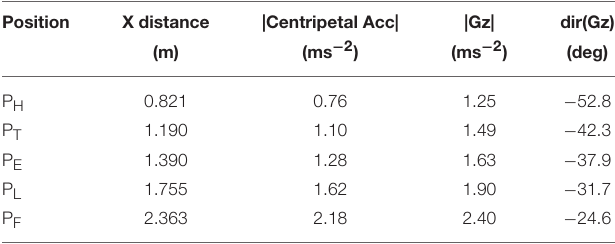
TABLE 1 | Resultant dynamics at five points along the head-to-foot body axis (tilted 24 ◦ downward) placed in the centrifuge (one revolution in